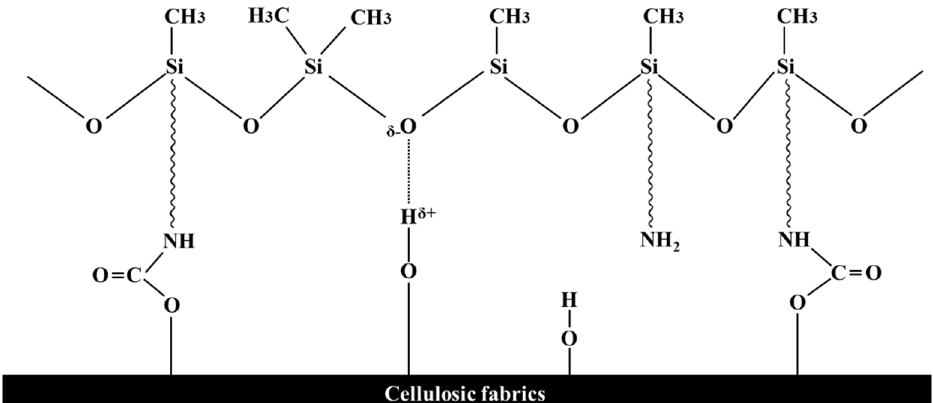
Figure 3. Crosslinking chemical mechanism of cellulosic fabrics and softeners.